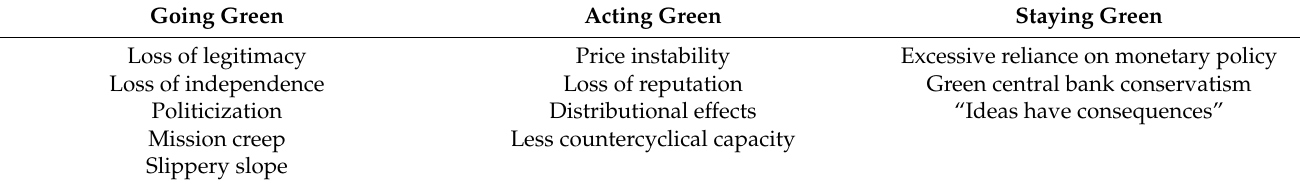
Table 2. The reinterpreted central banking template: costs and trade-offs of green central banking. Going Green Acting Green Staying Green Loss of legitimacy Price instability Excessive reliance on monetary policy Loss of independence Loss of reputation Green central bank conservatism Politicization Distributional effects “Ideas have consequences” Mission creep Less countercyclical capacity Slippery slope Source: own